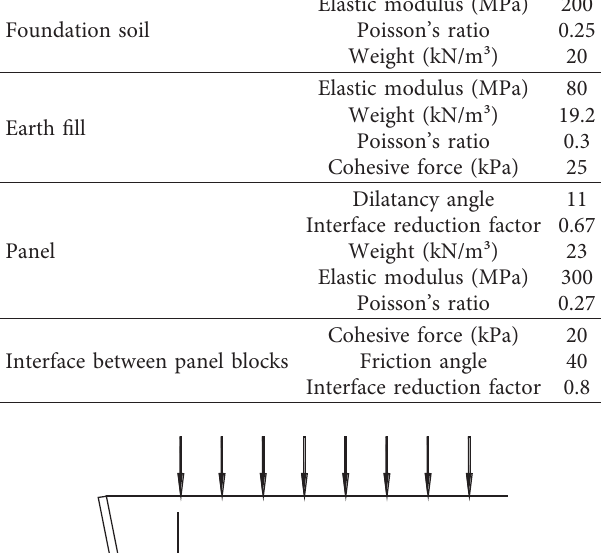
Table 3: Material parameters of the retaining wall. Foundation soil